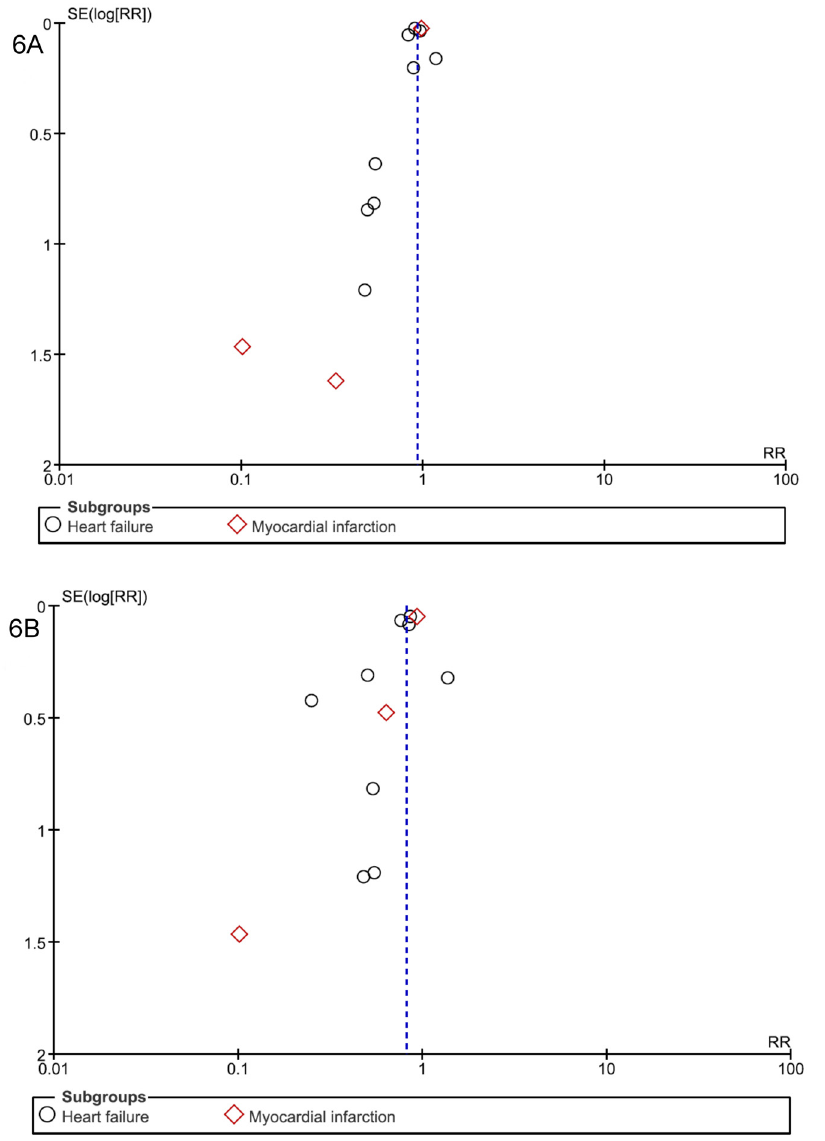
Fig 6. Funnel plot of standard error (log odds ratio) by odds ratio to evaluate publication bias for effect of aldosterone antagonist treatment in preventing (A) All-cause hospitalization and (B) Cardiovascular hospitalization in patients with heart failure or myocardial